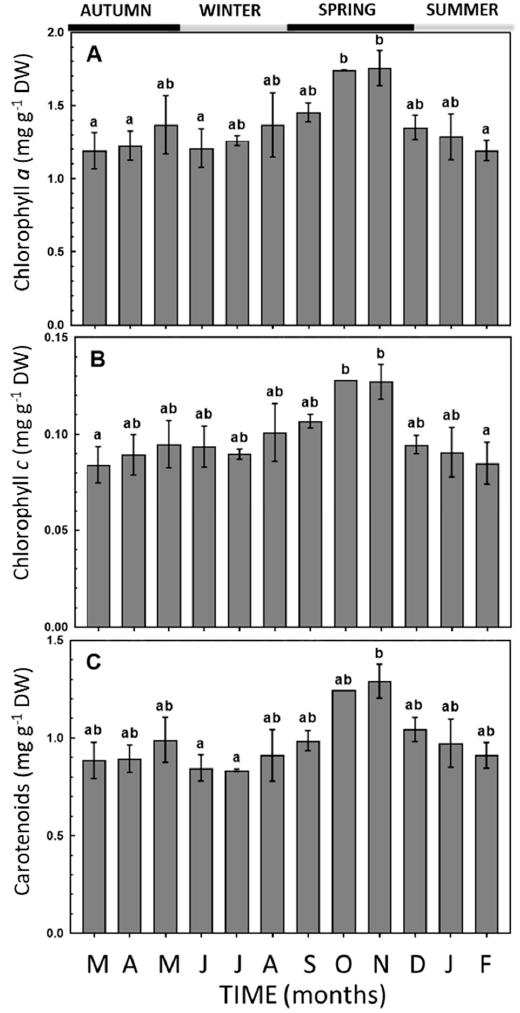
Figure 8. Photosynthetic pigments: ( A ) chlorophyll a , ( B ) chlorophyll c, and ( C ) total carotenoids, quantified in L. spicata at Cochoa Beach, Viña del Mar, Chile, from autumn to summertime. Letters indicate significant differences after the SNK test ( p < 0.05).